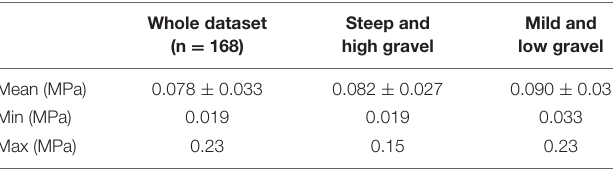
TABLE 4 | Descriptive statistics of standard deviation for measured (observed) (cid:57) stem